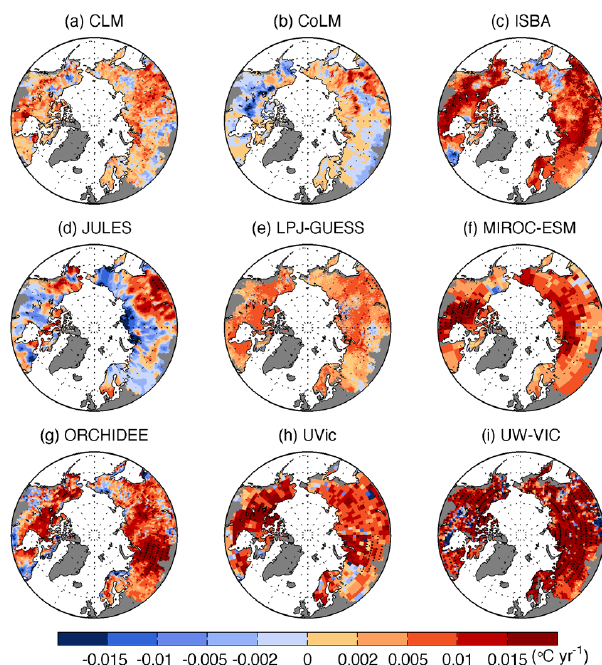
Figure 6. Spatial distributions of difference in trends of annual T s at 0.2 and 3m over boreal regions from 1960 to 2000 in (a) CLM, (b) CoLM, (c) ISBA, (d) JULES, (e) LPJ-GUESS, (f) MICRO- ESM, (g) ORCHIDEE, (h) UVic, and (i) UW-VIC models. The black dots indicate statistically significant difference by t test ( P <0.05). Note that extreme values outside of the range of − 0.015 to 0.015 ◦ Cyr − 1 are shown in the deepest blue and red in the color